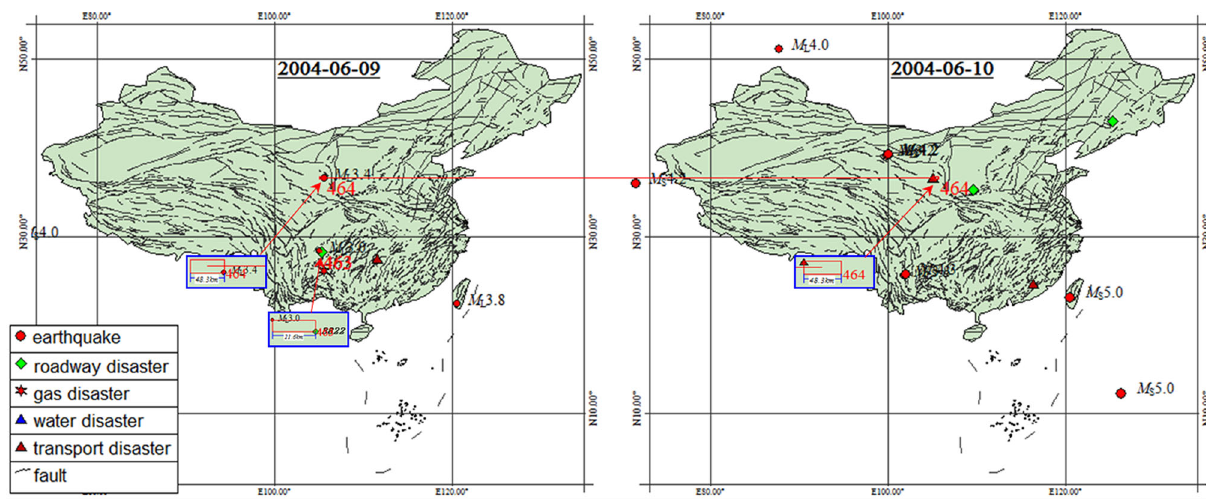
Fig. 4 Earthquakes and coal mine disasters occurring during the period from 9 to 10 June 2004